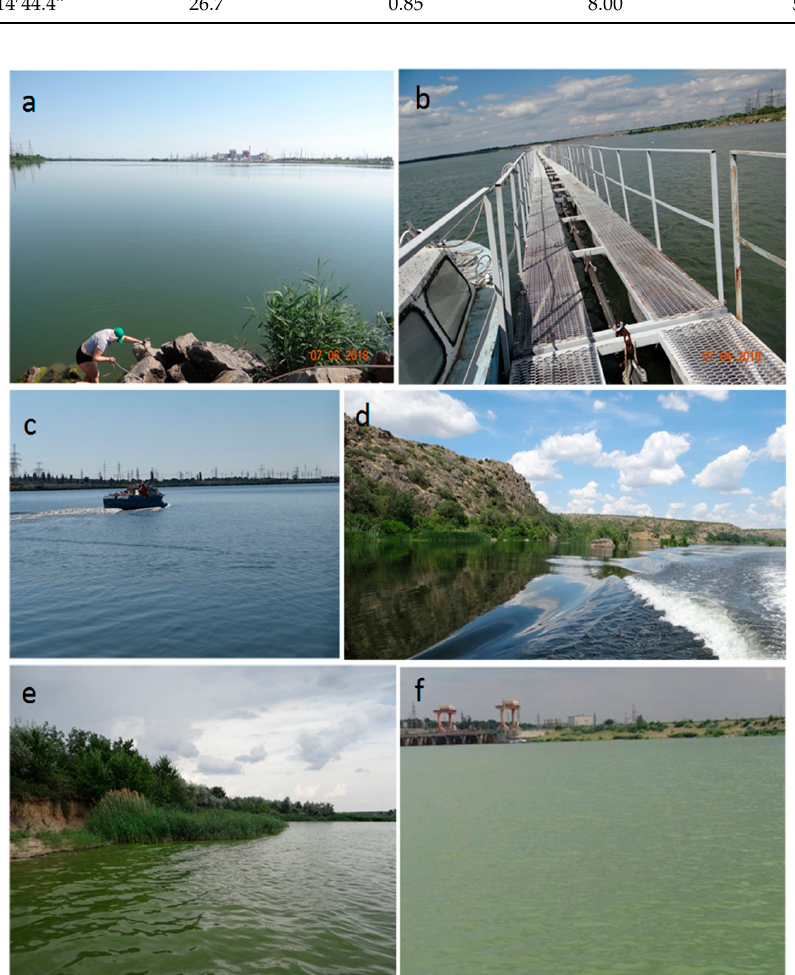
Figure 2. General view of water bodies: ( a )—general view of the Tashlyk reservoir from the dam; ( b )—training curtain, on the right heated water discharge area, st. 61a; ( c )—the lower part of the Tashlyk reservoir, st. 60; ( d )—Alexandrovskoe reservoir, upper part; ( e )—Alexandrovskoye reservoir, lower part; ( f )—Alexandrovskoe reservoir, near dam part.